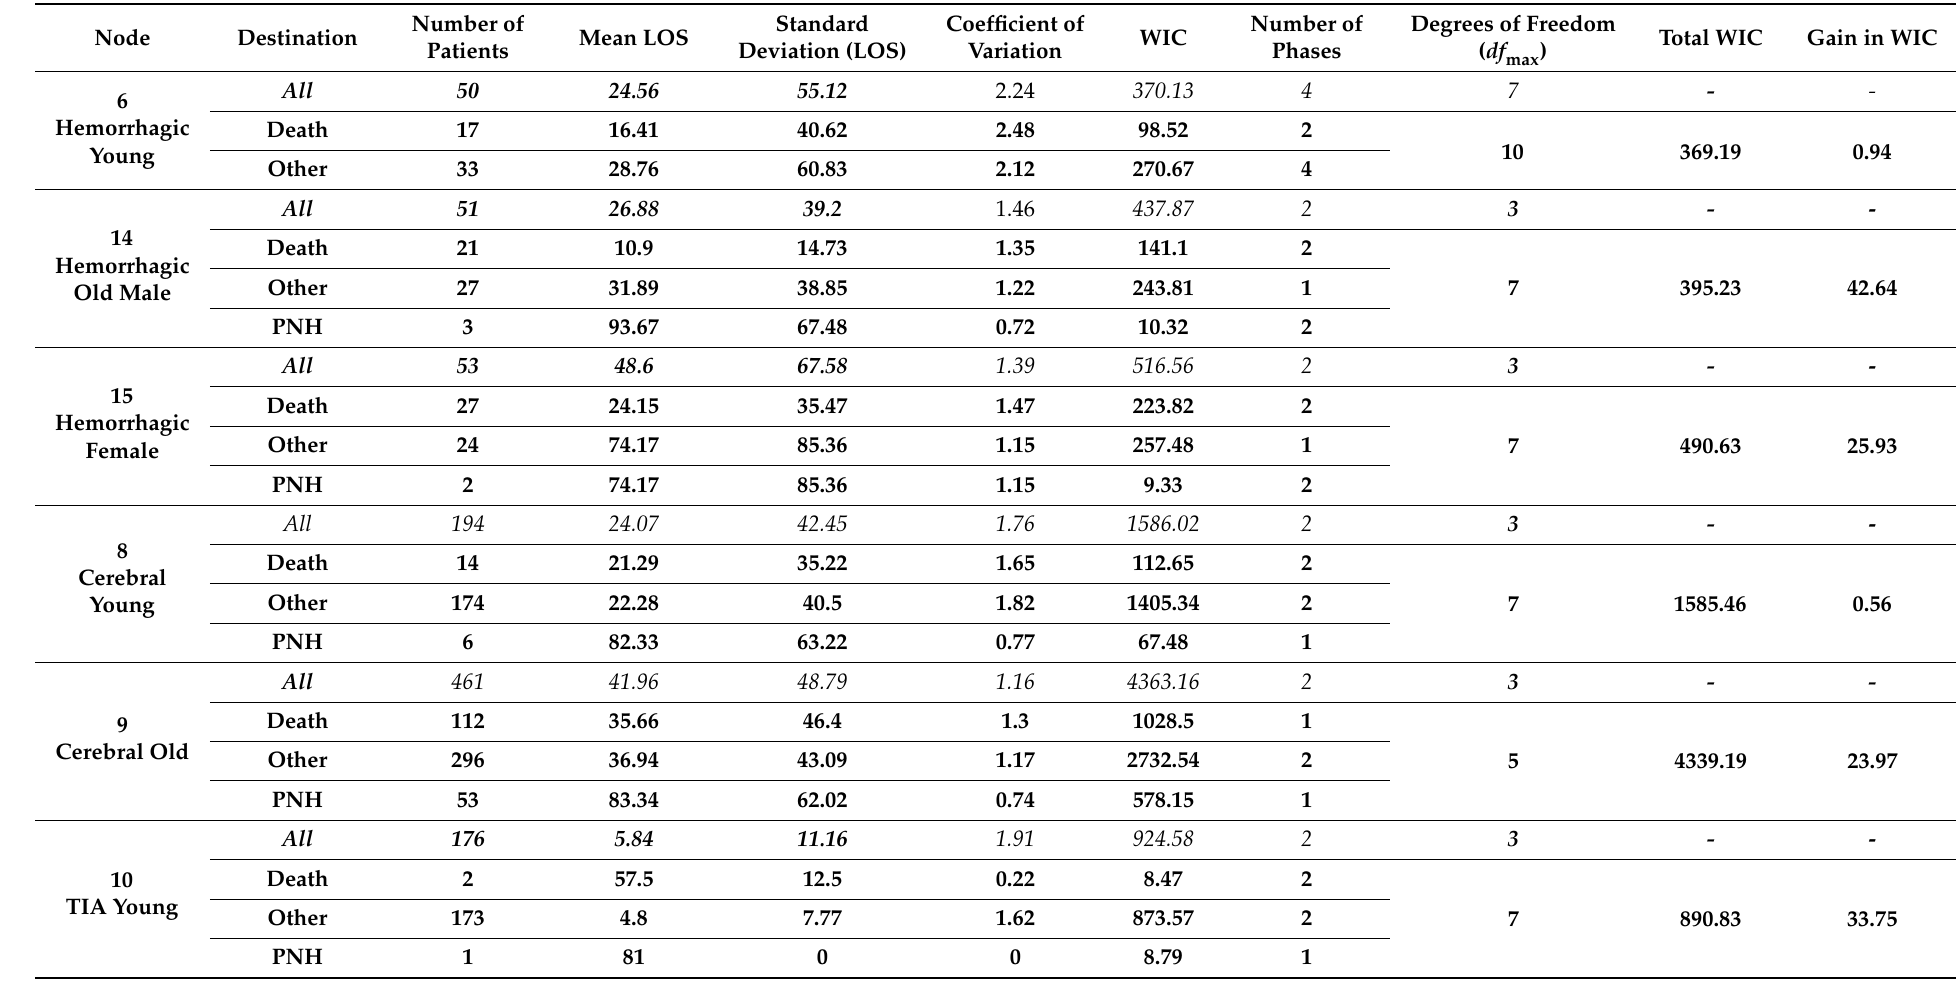
Table 2. Tree extension using the WIC-based splitting criteria (nodes and possible splits by the covariate discharge